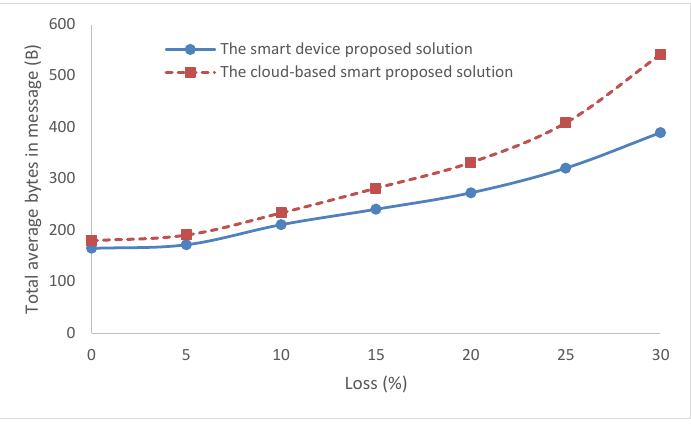
Figure 10. The total average bytes in message. Table 2. The total average bytes in message for the two solutions with network loss.